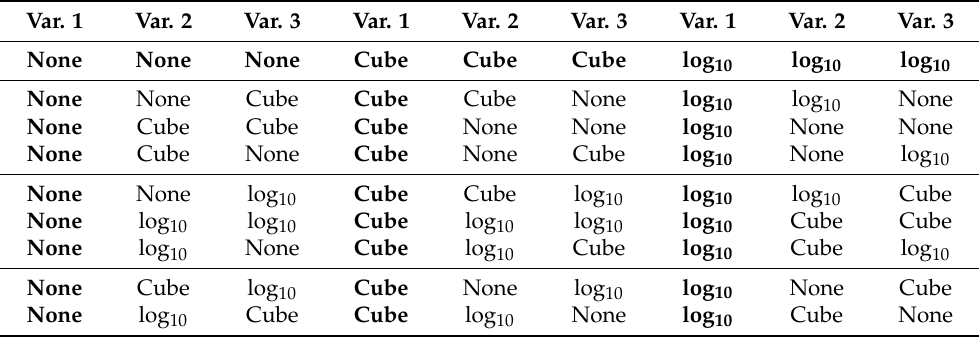
Table 1. The 27 possible data combinations of three variables (Var.) each of which are subjected to three data transformations in the same analysis: none, cube root, or log 10 . Two distinct assemblages were used in the “Data-Transformation Experiment” to address the second objective—establish the best combination of data transformation for the discrimination of oil spills from look-alike slicks. Baseline combinations with the same transformation are given in the first row. “Metoc Assemblage”: wind speed (WND), sea-surface temperature (SST), and chlorophyll-a concentration (CHL). “Size Assemblage”: area, aspect ratio (length-to-width ratio: LtoW), and number of parts of each feature (NUM)—see also Figure 4 in Carvalho et al. [42]. See also Section 3.1.3. Var. 1 Var.